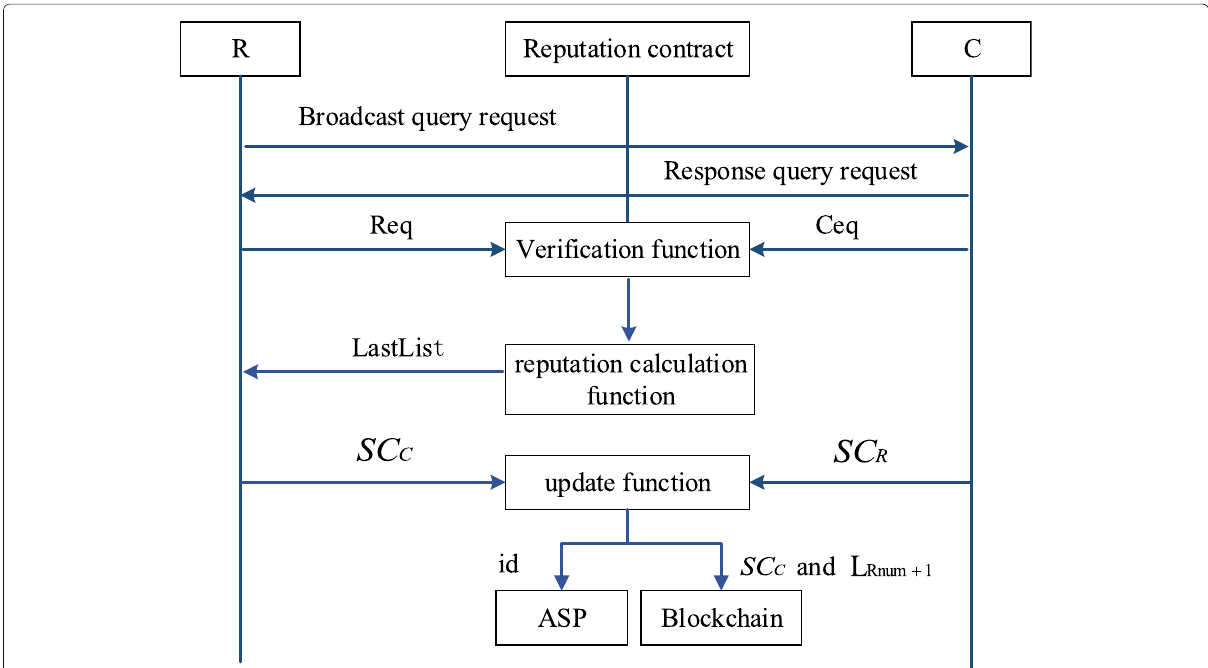
Fig. 4 The interaction process of anonymous domain